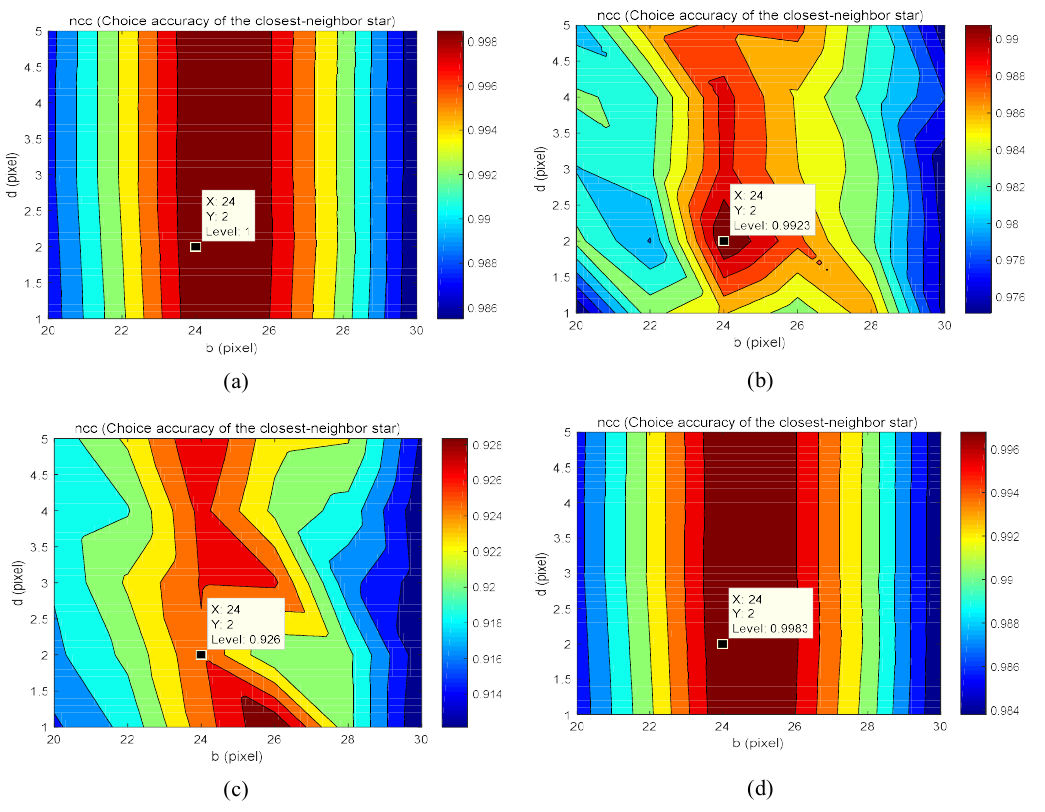
Figure 12. Choice accuracy of the closest-neighbor star ncc under different radius thresholds b and different position tolerance scales d . ( a ) For ideal cases. ( b ) For cases with 0.1-pixel positioning error. ( c ) For cases with 1 missing star. ( d ) For cases with 1 false star.